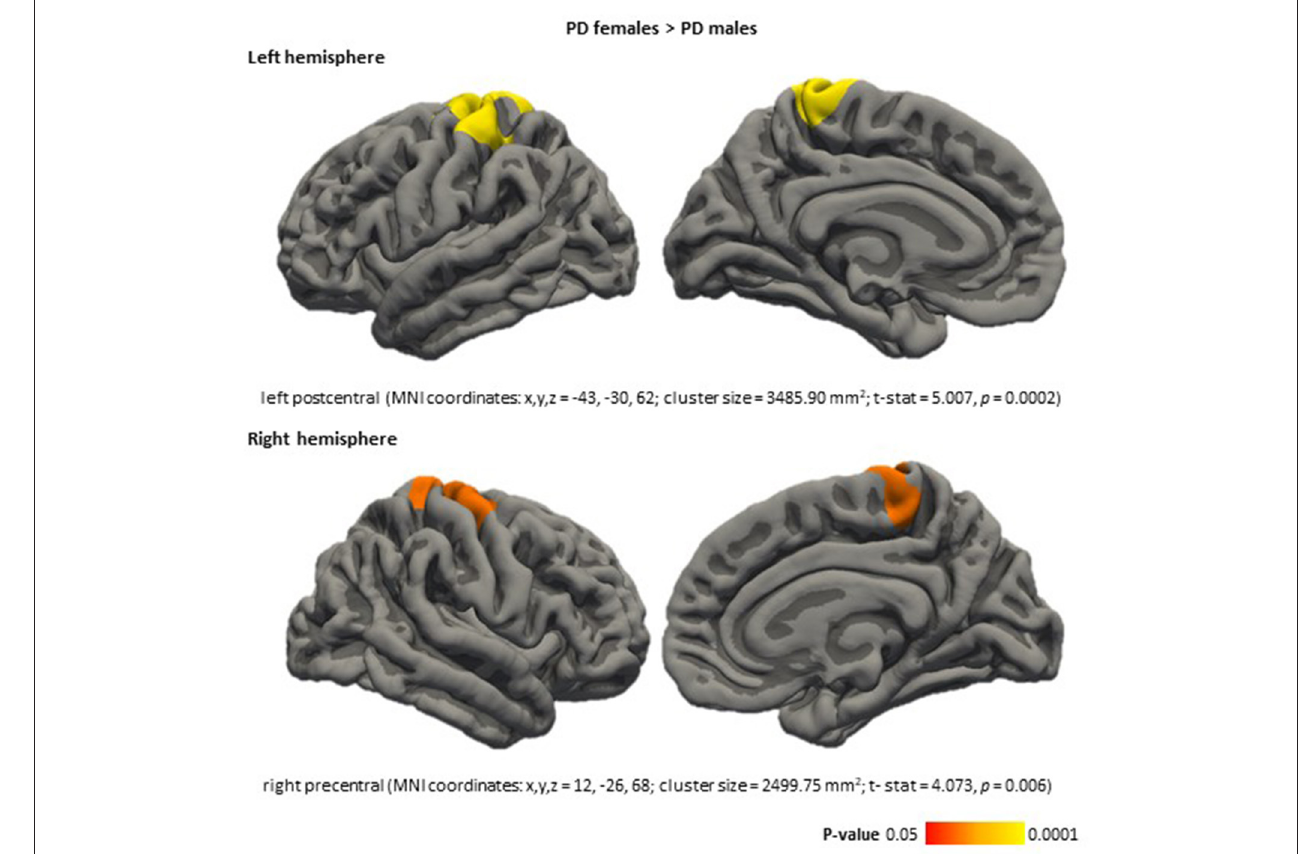
FIGURE 2 | Cortical thickness differences between PD females and PD males, in the PD females > PD males direction. Color maps indicate clusters with significant differences (corrected p < 0.05). Results were corrected by Monte Carlo simulation. Detailed information is included for each significant cluster: cortical area, MNI coordinates (x, y, z), cluster size (mm 2 ), test stat ( t -stat), and P -value ( p ). PD, Parkinson’s